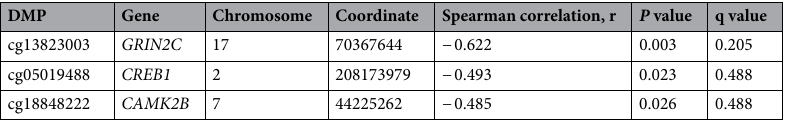
Table 2. Correlation between the methylation changes with the changes in recovery symptoms: the three identified DMPs and the corresponding genes. a P value, uncorrected P value, 2-tailed; q value, FDR-corrected P value.